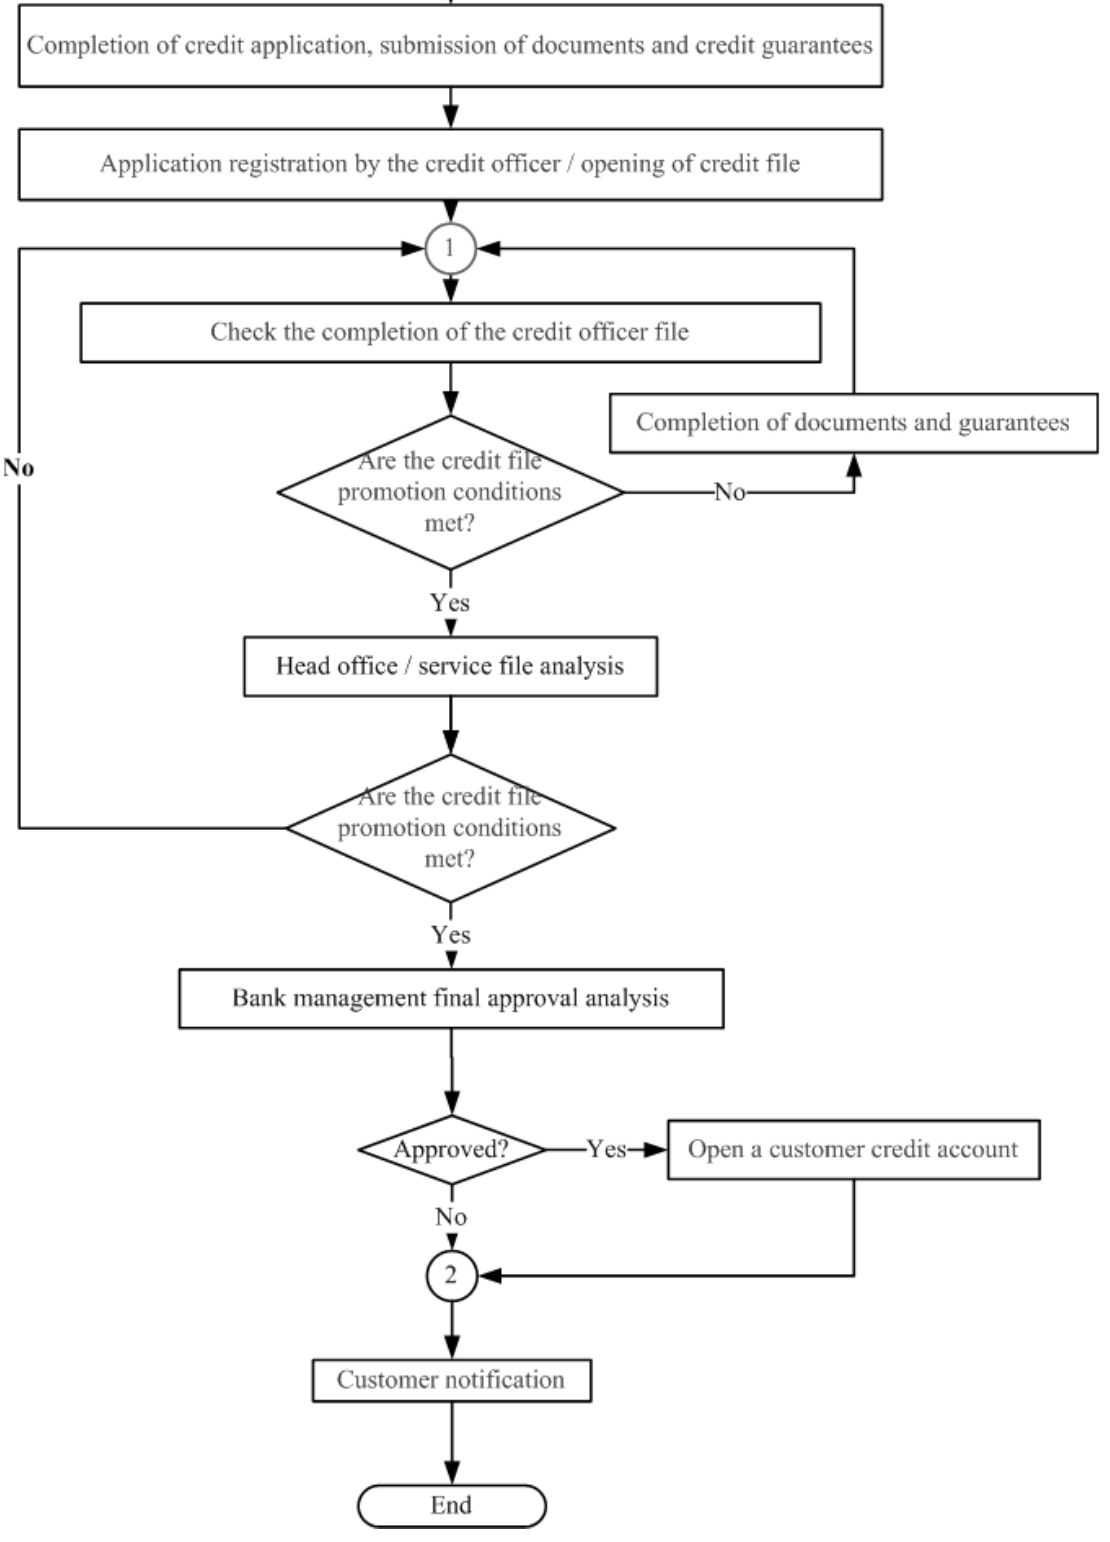
Figure 1. Workflow - graphical